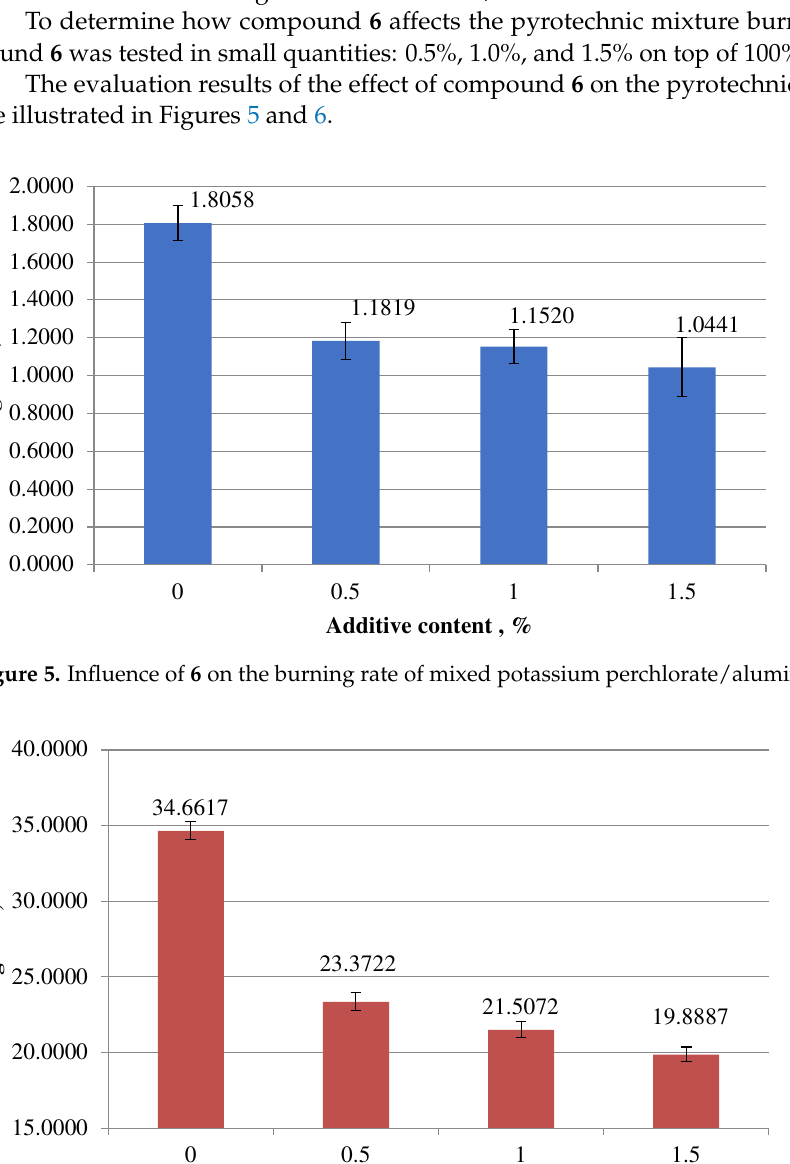
Table 4. Burning rate as a function of the content of 6 in the pyrotechnic mixtures used in the pre- sent study.